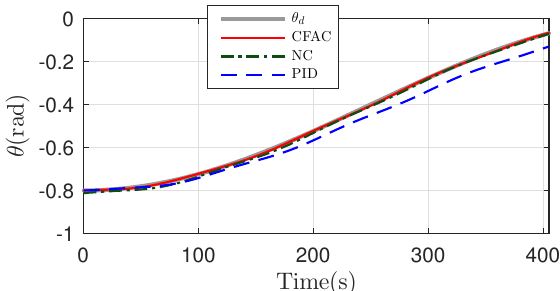
Figure 29. Pitch angle tracking performance in virtual mooring.